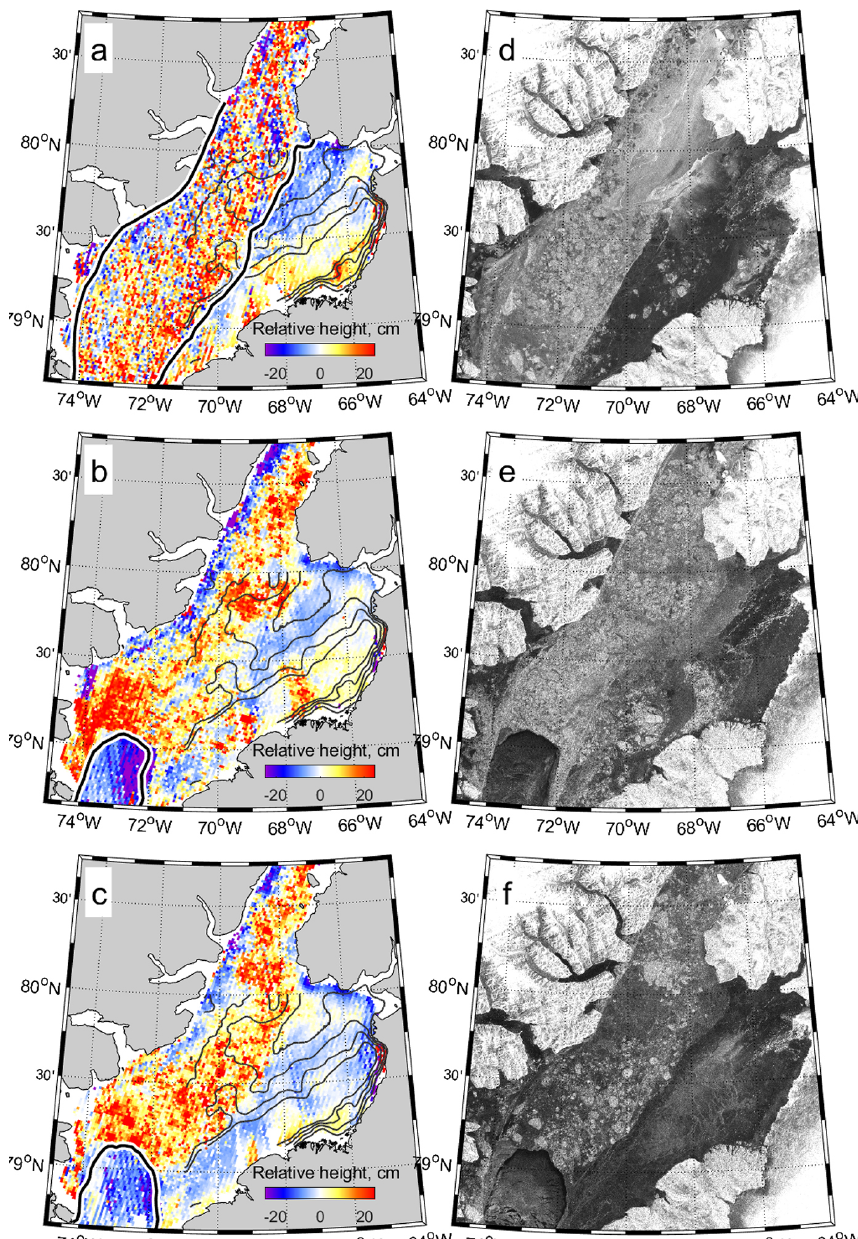
Figure 4. (a–c) The along-track anomalies of ATL07 elevations averaged over 1 . 5 × 1 . 5km cells in January–April 2019 (a) , 2020 (b) and 2021 (c) . The thick black lines correspond to approximate positions of landfast ice edge during these winters. (d–e) Sentinel-1 SAR images from 16 January in the corresponding